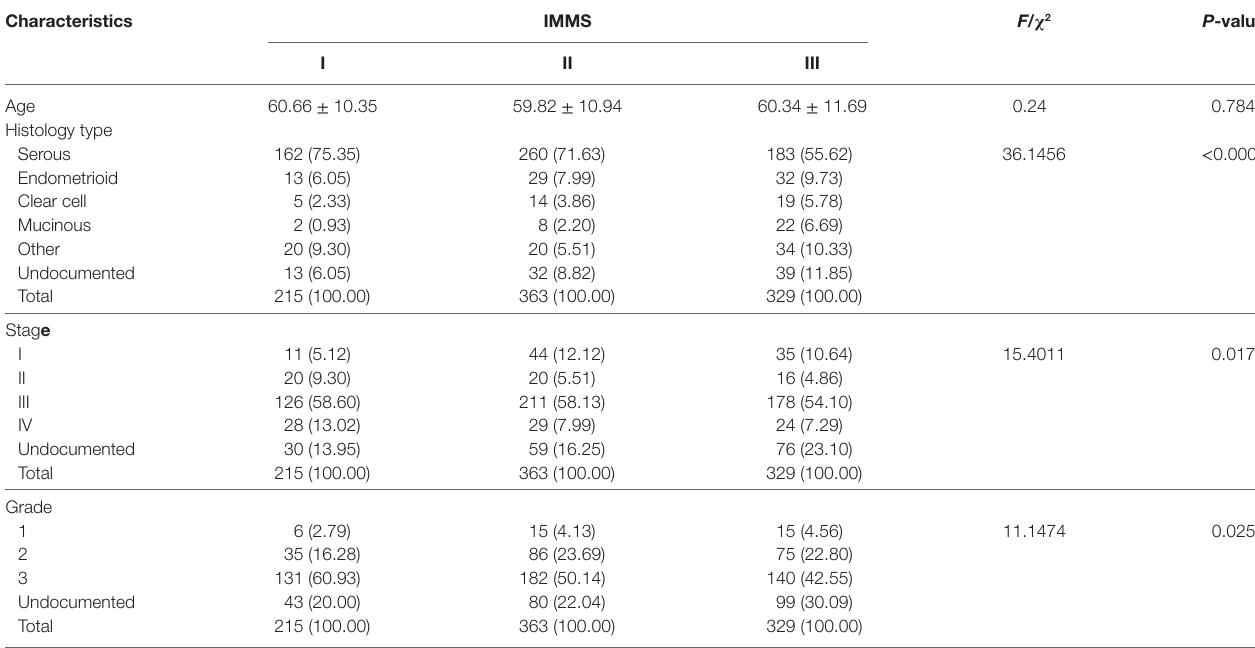
Table 1 | Clinical characteristics of patients.